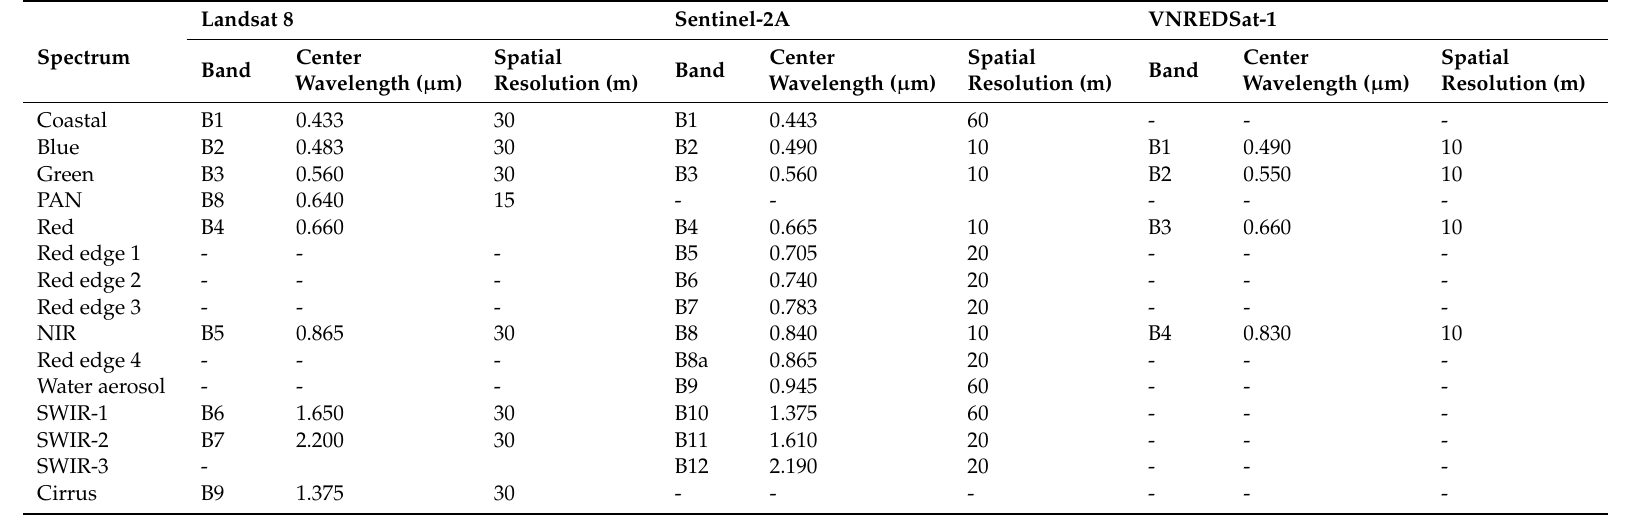
Table 1. Wavelengths and spatial resolution characteristics of Landsat 8, Sentinel-2, and Vietnamese Natural Resources, Environment, and Disaster Monitoring Satellite (VNREDSat-1)